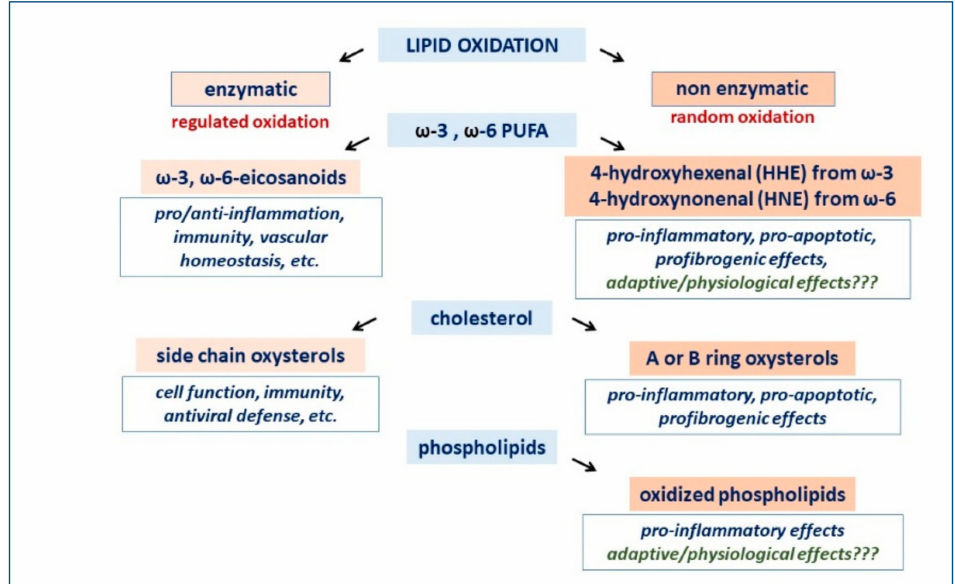
Figure 2. Enzymatic and non-enzymatic products of lipid